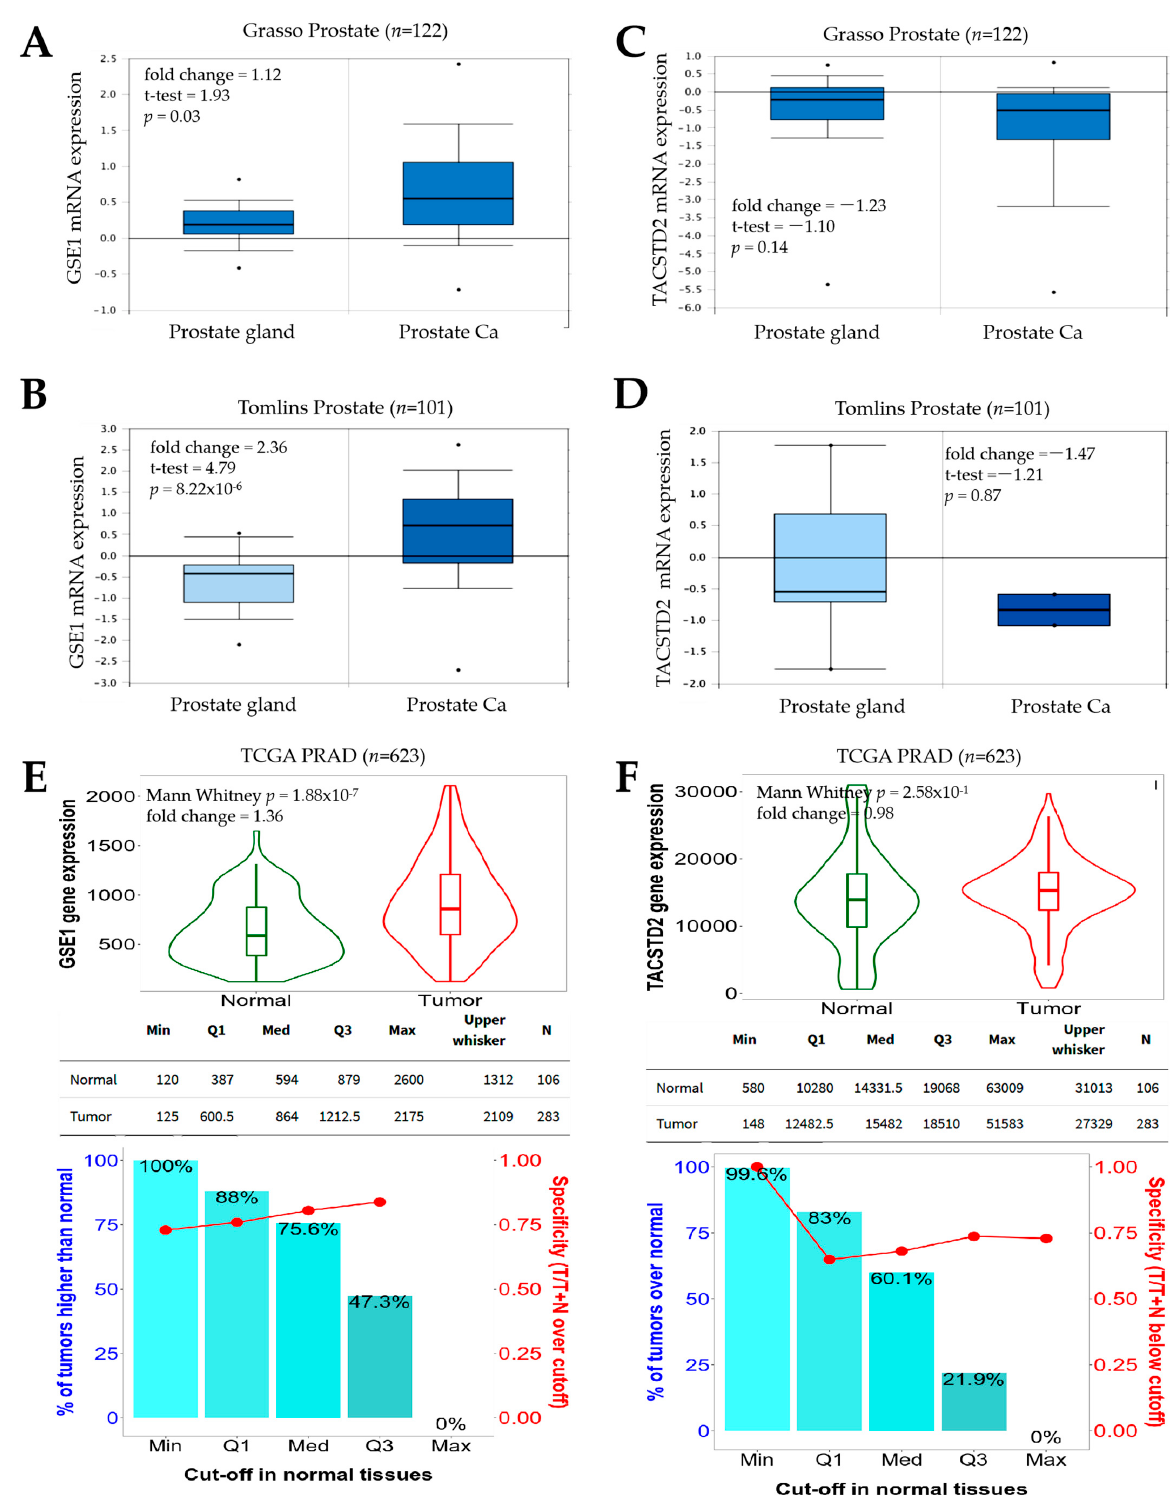
Figure 1. Increased GSE1/TACSTD2 expression ratio defines patients with prostate cancer. Box-and-whisker plots showing the differential expression of GSE1 mRNA in prostate glands and prostate cancer in the ( A ) Grosso and ( B ) Tomlins Prostate cohorts. Box-and-whisker plots showing the differential expression of TACSTD2 mRNA in prostate glands and prostate cancer in the ( C ) Grosso and ( D ) Tomlins Prostate cohorts. Violin plots showing the differential expression ( top ) and expression cut-off chart ( bottom ) of ( E ) GSE1 and ( F ) TACSTD2 in normal and tumor samples in the TCGA PRAD cohort. TCGA, The Cancer Genome Atlas; PRAD, Prostate